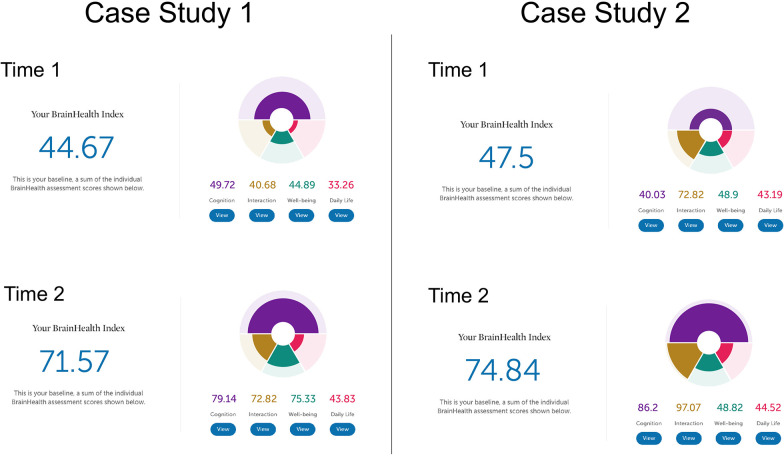
Two case studies.